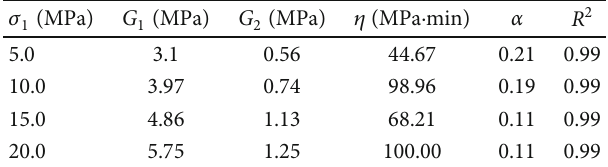
Table 1: Parameters of fractional Poynting-Thomson